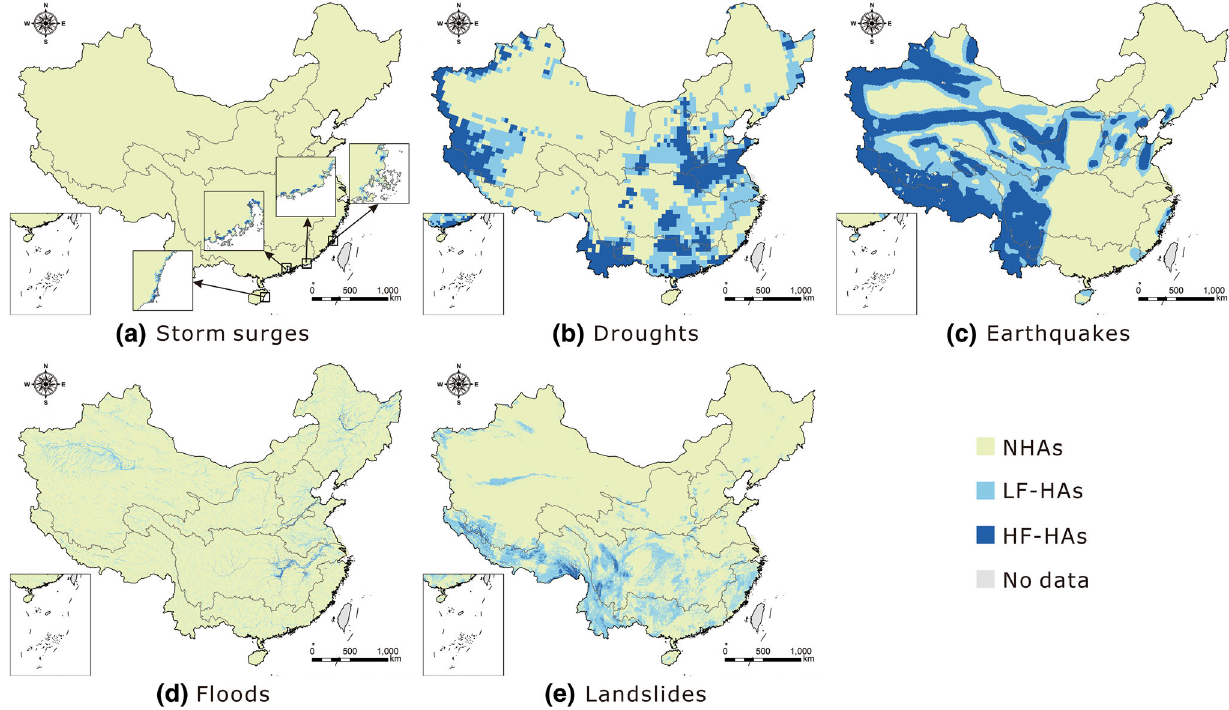
Fig. 2 Hazard area classification for a storm surges, b droughts, c earthquakes, d floods, and e landslides in China in 2015. NHAs Non-hazard areas, LF - HAs low-frequency hazard areas, HF - HAs high-frequency hazard